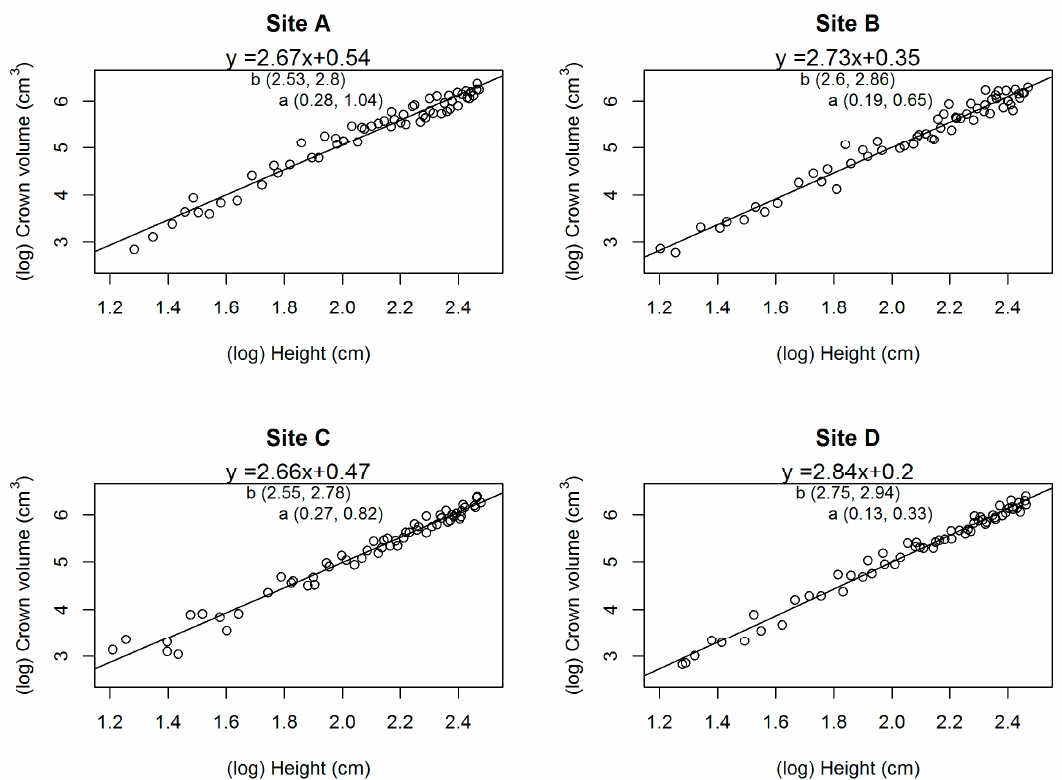
Figure 4. Linear regression models for the allometric scaling of crown volume over height. Regression equations are shown above each plot. Black lines represent the regression model. Dots represent observations. Values in brackets are the 95% confidence intervals (C.I.) of the slope (b) and intercept (a) coefficients.